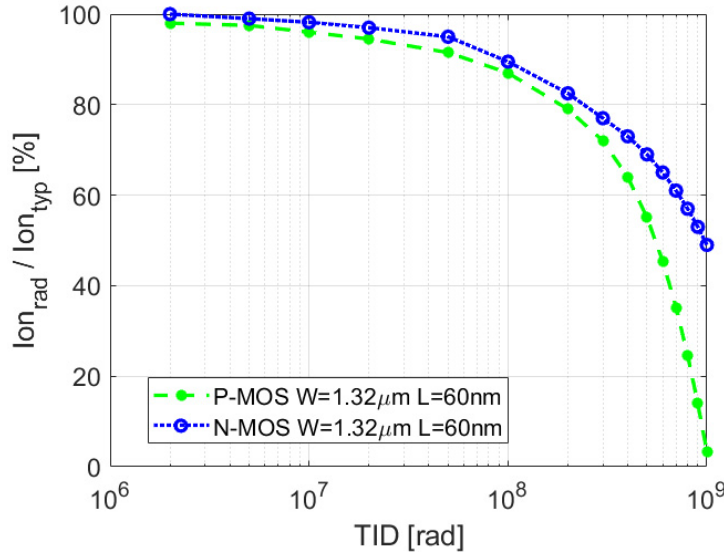
Figure 3. Percentual variation of the on-current of minimum size MOSFETs connected as a diode (the gate is connected to the drain) as a function of TID.